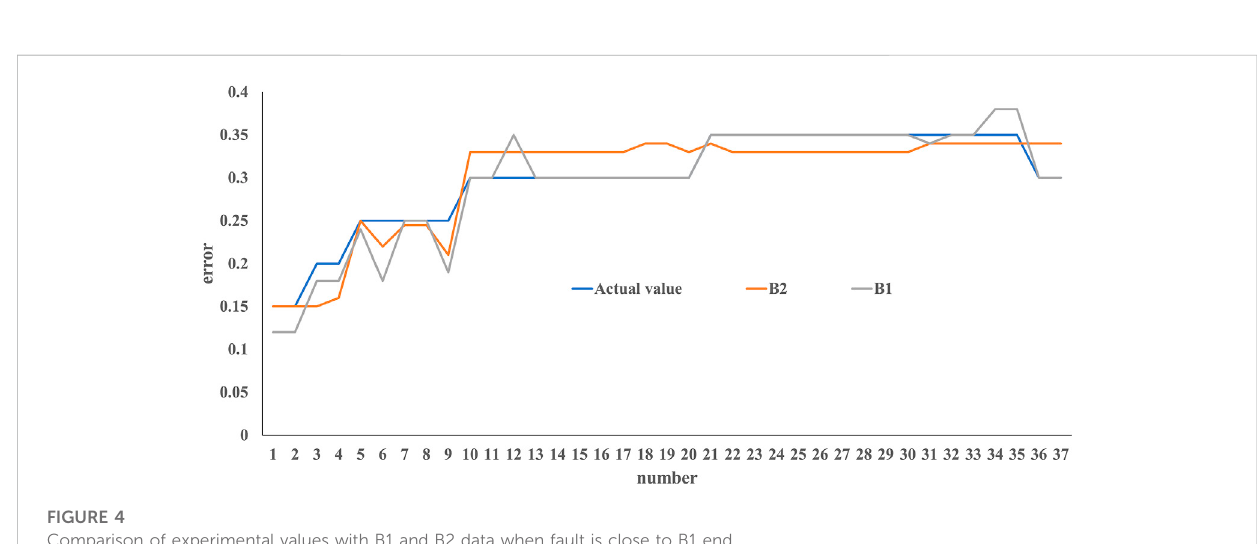
FIGURE 4 Comparison of experimental values with B1 and B2 data when fault is close to B1